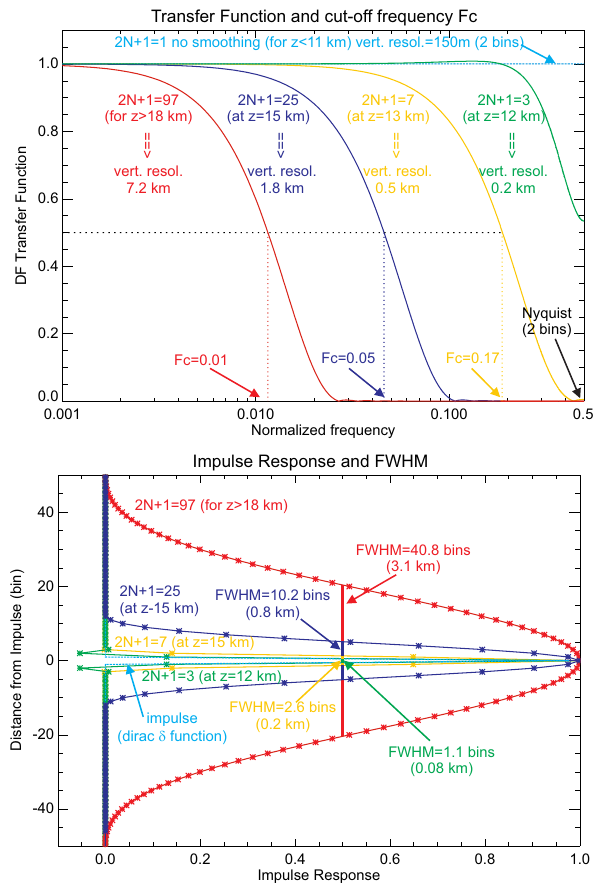
Fig. 2. Effect of the TMW lidar signals vertical filtering based upon two different vertical resolution definitions. Top plot: definition based on the cut-off frequency of a digital filter (Kaiser filter with 50dB attenuation). Bottom plot: definition based on the full-width at half-maximum (FWHM) of an Impulse Response to a Dirac Delta Function.